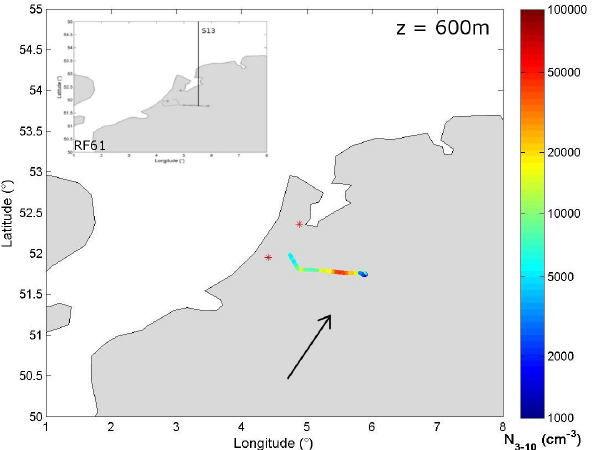
Fig. 6. As for Fig. 3 for research flight RF61 on 28 May (Group IV event).